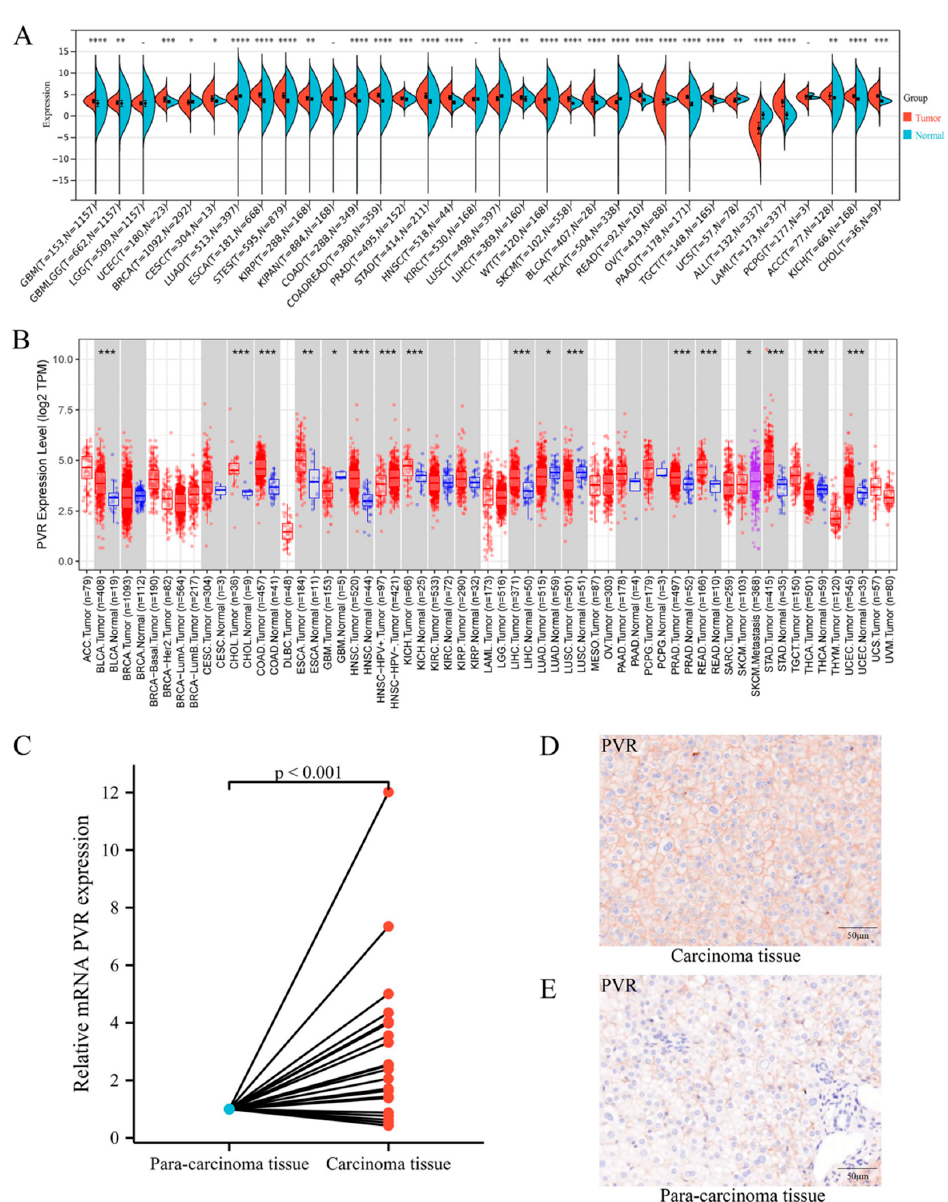
Figure 1. PVR was upregulated in pan-cancer including HCC. ( A , B ) The expression of PVR in pan-cancer obtained from the Sangerbox and TIMER database. ( C ) mRNA level of PVR in HCC and paracancer tissues collected from Zhongshan hospital. ( D , E ) The protein expression of PVR in the tumor tissue and paracancer tissues of HCC patients. * p value < 0.05; * * p value < 0.01; ** * p value < 0.001; **** p value < 0.0001.